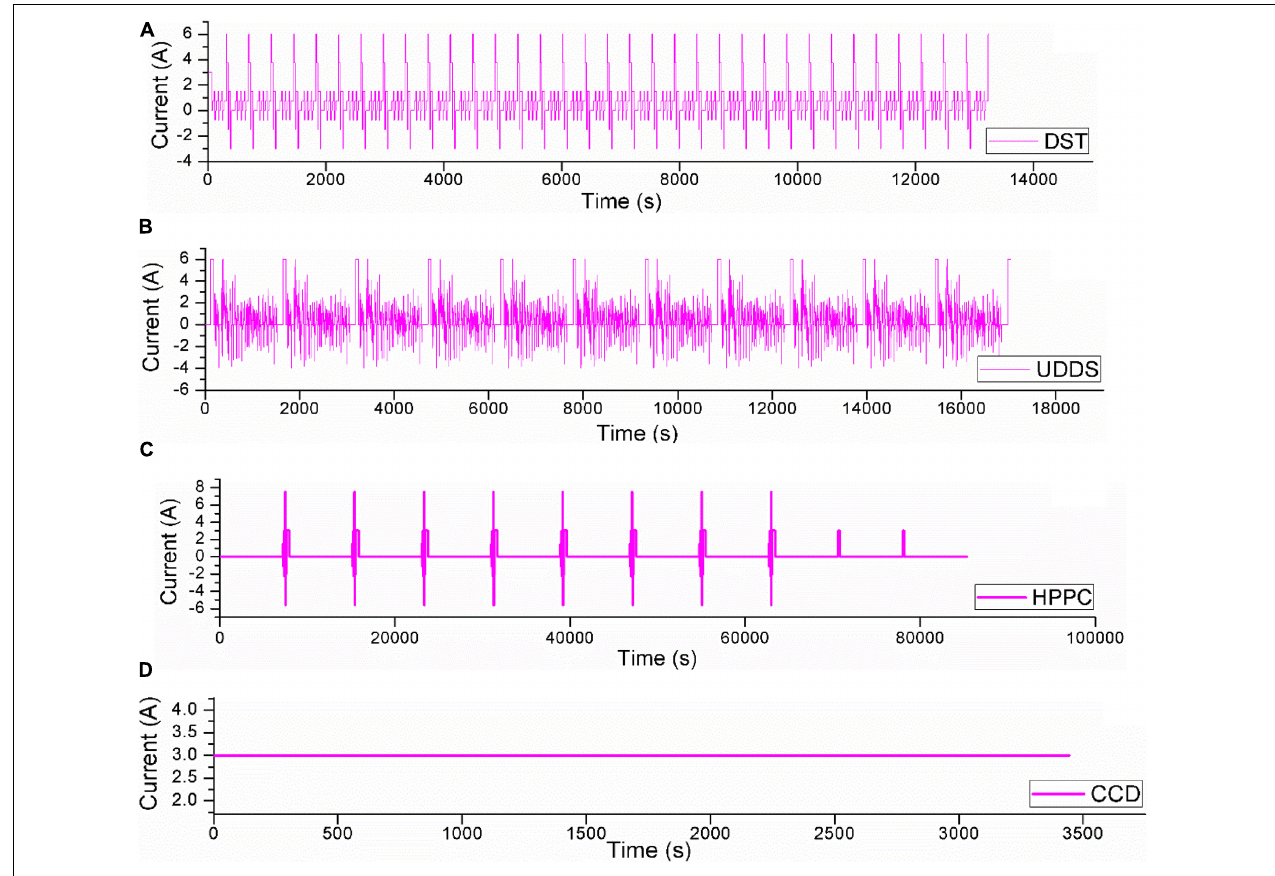
FIGURE 4 | Discharging current profiles. (A) DST; (B) UDDS; (C) HPPC; (D) CCD.